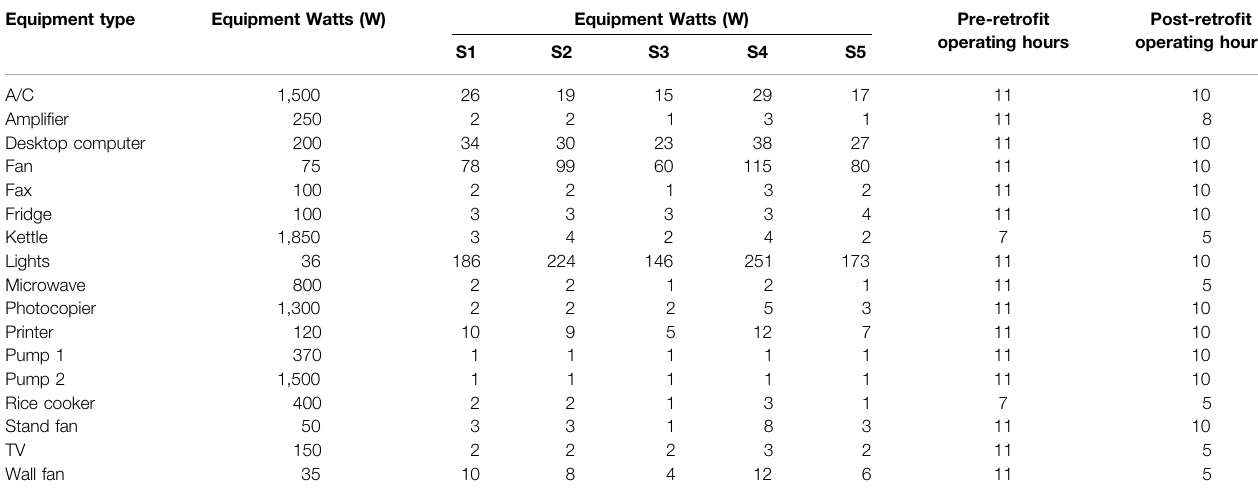
TABLE 3 | Summary list of electrical equipment in schools. Equipment